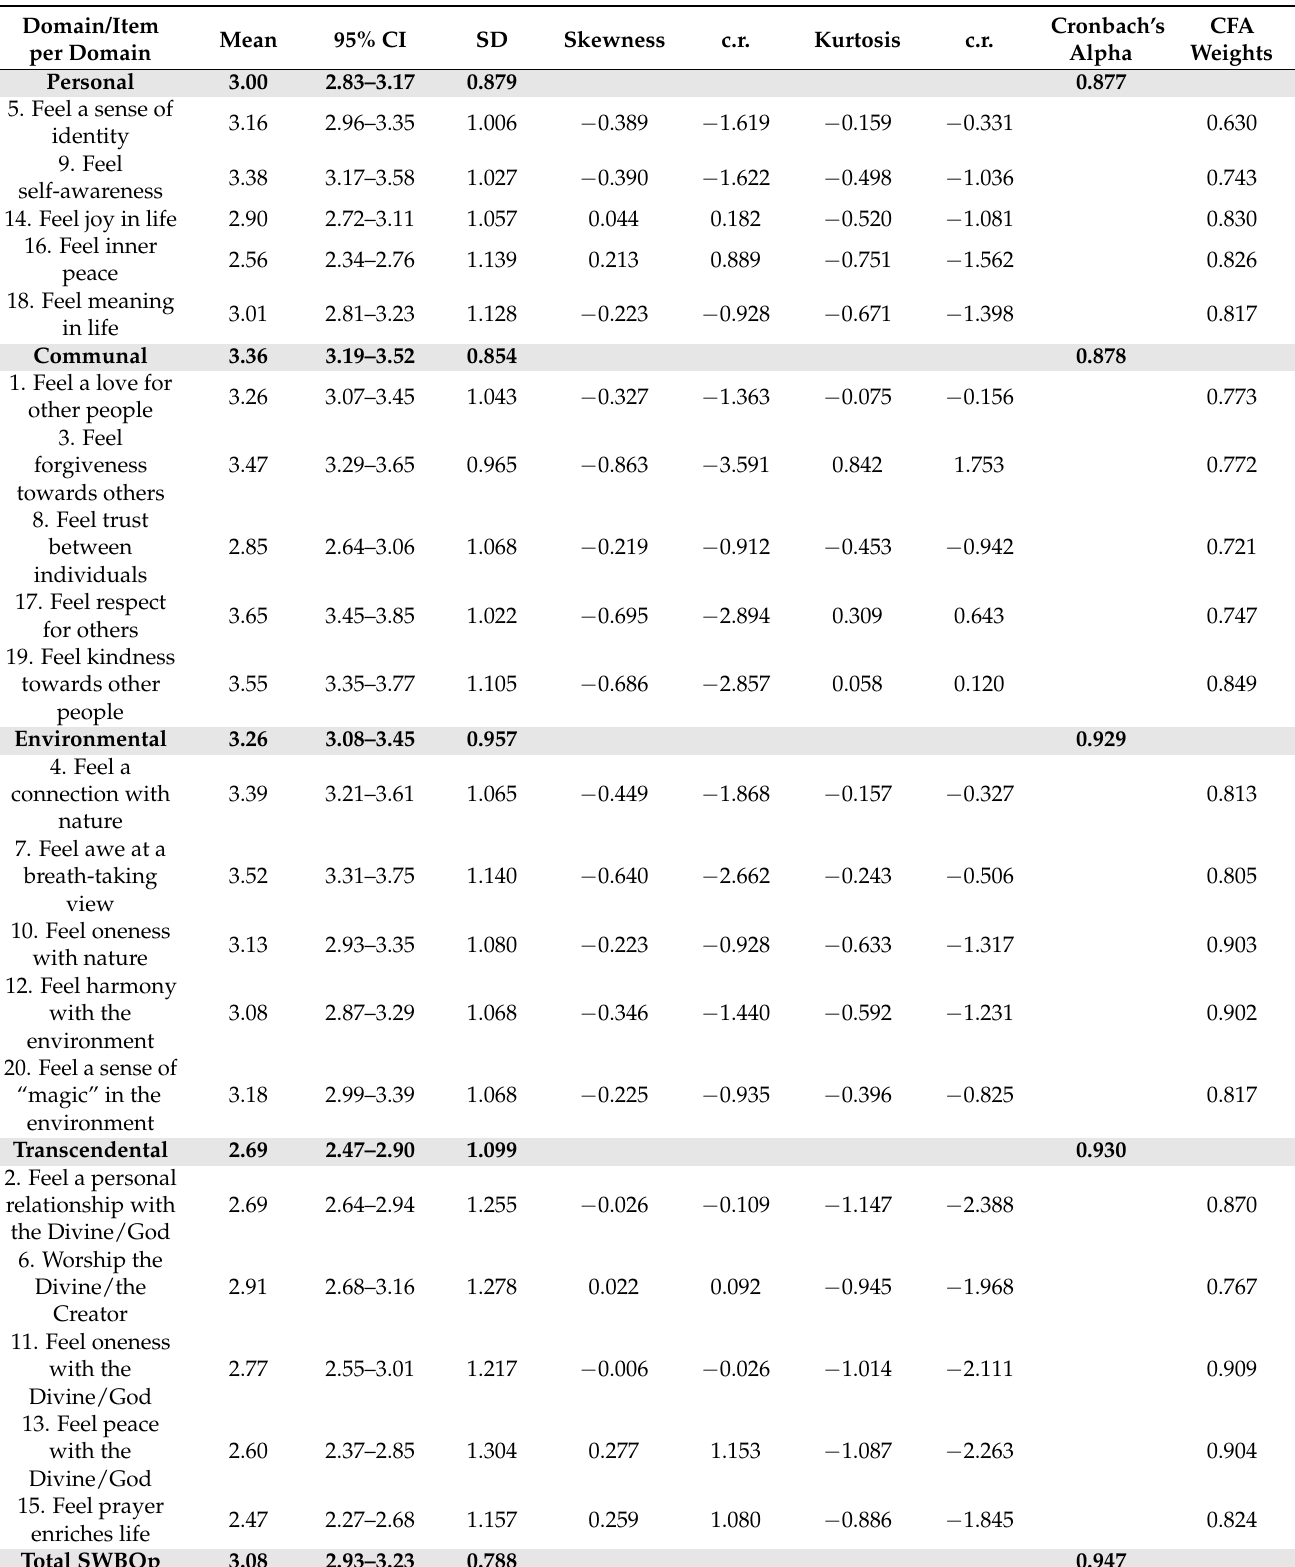
Table 2. Descriptive statistics, Cronbach’s alpha coefficient of the SWBQp factors/domains, and CFA assessment of normality of